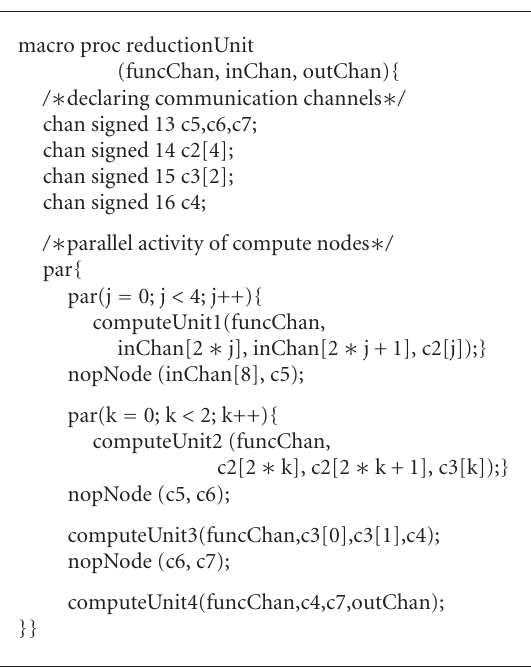
Algorithm 3: Code example for the reduction computing unit (intermediate macro procedure).